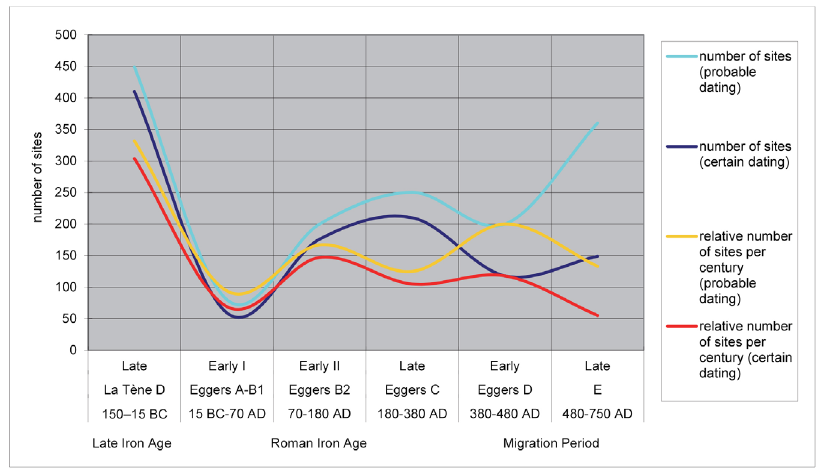
Figure 2. Graph showing sites in the Bavarian District of Lower Franconia in the research area at the Main River. Shown are the numbers of sites in the area under investigation at the Main from the Late Iron Age (La Tène D) through the Roman Iron Age Periods A–C to the Early and Late Migration Period D–E (author credit). Here the absolute numbers of sites are represented